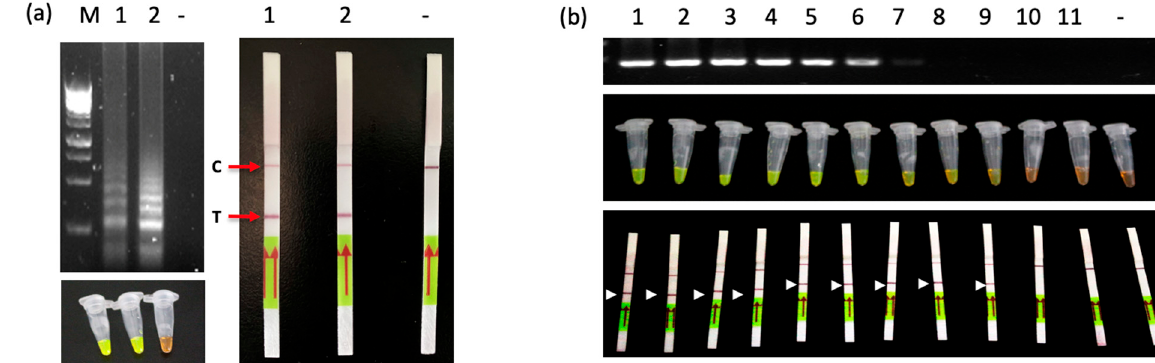
Figure 4. Analytical specificity and sensitivity of LAMP-LFD assays in detecting ChTBV1. ( a ) Establishment of a ChTBV1 LAMP-LFD assay. Top left panel: LAMP products visualized by gel electrophoresis; Bottom left panel: LAMP products visualized with SYBR Green I dye; Right panel: LAMP products visualized with LFD strips. Lane M: GeneRuler 1 kb Plus DNA Ladder; Lane1: DNA extracted from ChTBV1 infected leaves. Lane 2: Plasmid containing the ChTBV1 sequence A1. Lane -: DNA extracted from uninfected leaves. C: control band; T: test band. ( b ) LAMP-LFD detection limits for ChTBV1 dilutions. Top panel: PCR assay sensitivity test; Middle panel: SYBR Green I-visual LAMP sensitivity test; Bottom panel: LAMP-LFD sensitivity test. M: GeneRuler: 1 kb DNA Ladder; Lanes 1 to 11: Ten-fold serial dilutions (10 0 to 10 − 10 ) of plasmid containing the ChTBV1 sequence (0.5 µ g/ µ L); lane -: Negative template control (sterile ddH 2 O).